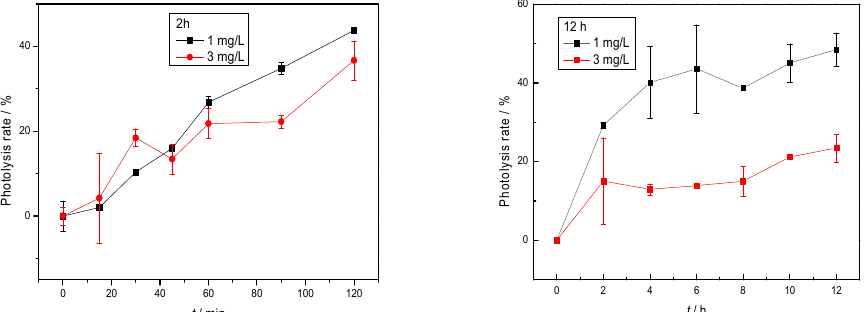
Figure 4. Removal rate of mebendazole during 2 h and 12 h of photolysis. Error bars represent the standard deviations ( n = 3).